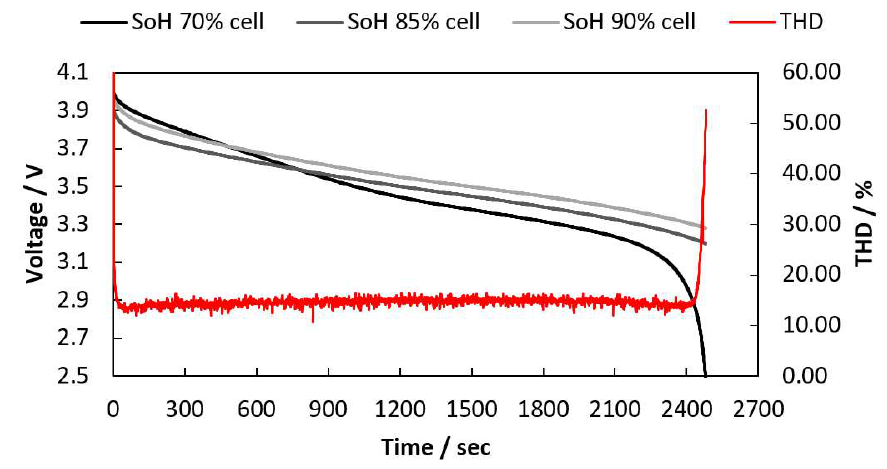
Figure 8. Voltage of each cell and THD measured during the discharge of the battery pack.